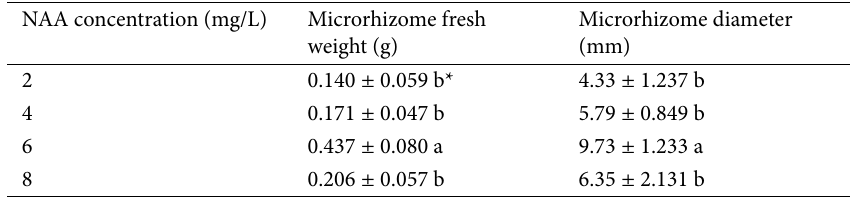
Table 5 Effect of NAA ( α -naphthaleneacetic acid) concentrations on microrhizome growth.